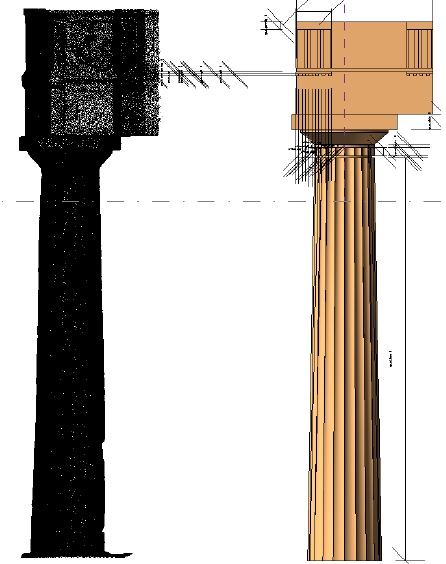
Figure 10. Adjusted dimensions of the parameterized column (right) based on the point cloud (left). (source: Kontoudaki, 2021)